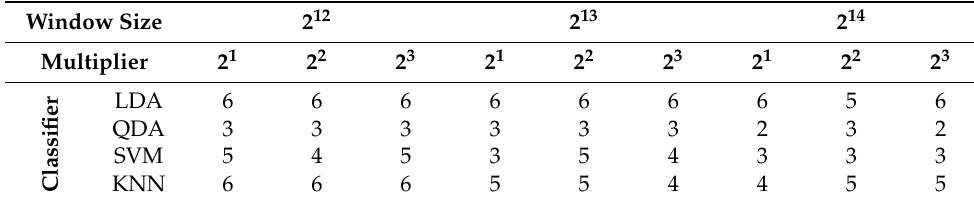
Table 2. False positives for crack presence (%) of different classification methods.